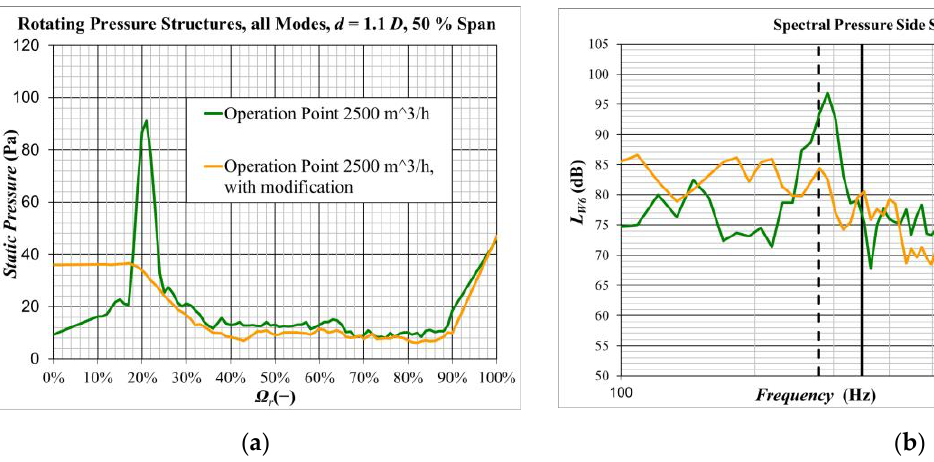
Figure 7. Results of the numerical investigation of a geometrical modification: ( a ) Sketch of the investigated geometrical modification; ( b ) instantaneous static pressure distributions with streamlines at a midspan plane cut for Q V = 2500 m 3 /h with installed modification; ( c ) static pressure distributions without modification.